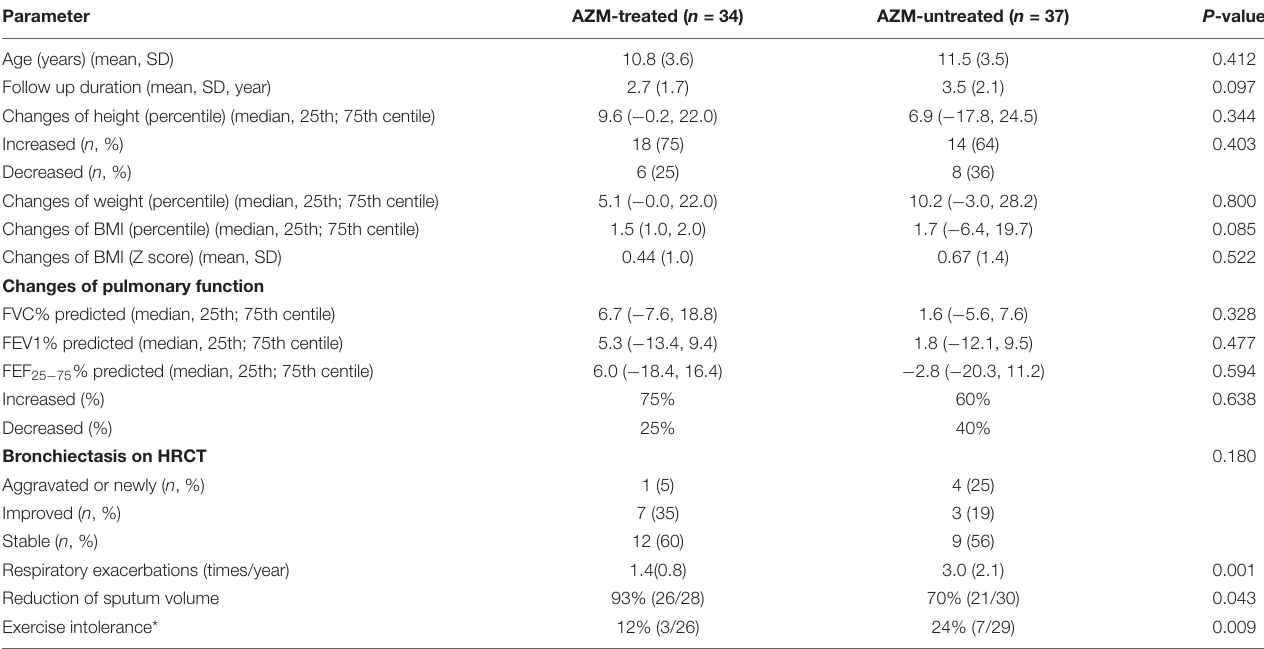
TABLE 3 | Clinical outcomes at follow-up of patients by treatment group.